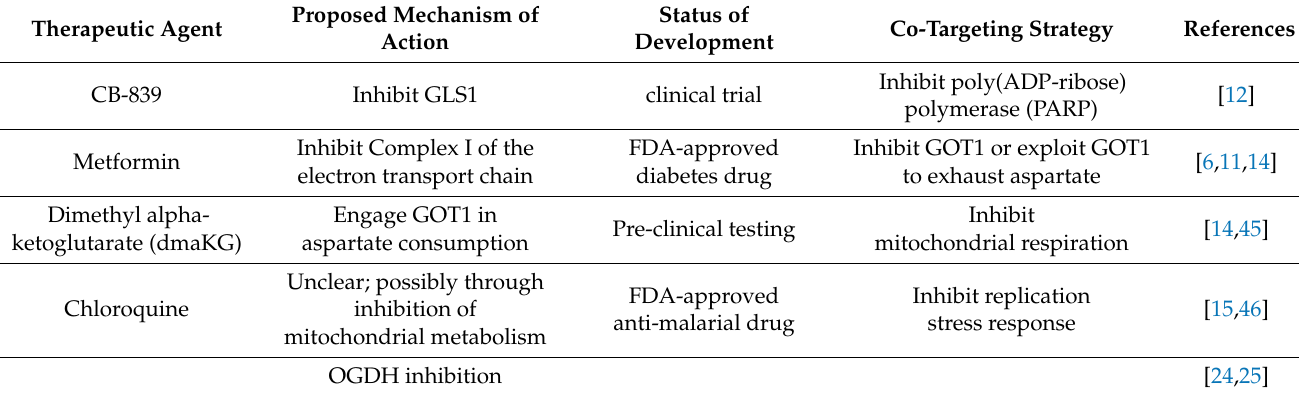
Table 1. Therapeutic approaches that deplete aspartate in cancer